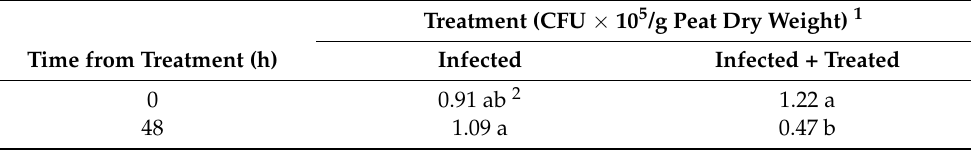
Table 4. Number of colony-forming units (CFUs) of Pythium ultimum 22 per gram of peat, on a dry weight basis, retrieved from the trays infected and treated with the undiluted giant reed extract, before and after the treatment (at 0 and 48 h) in comparison with the infected and nontreated trays.